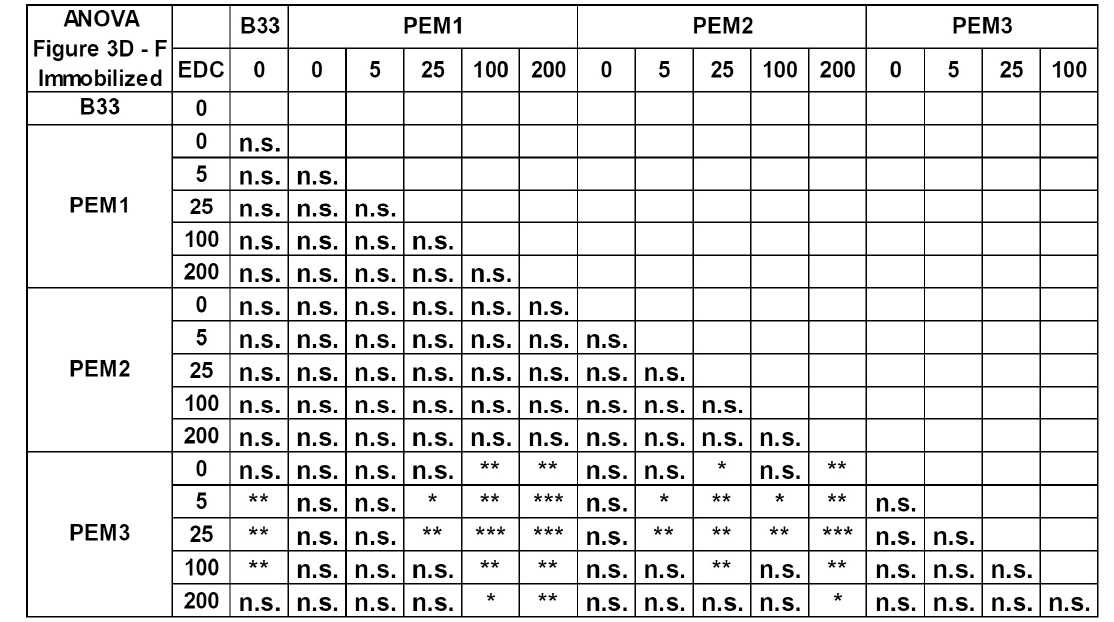
Figure A1. Results of one-way ANOVA for data related to Figure 3A–C; n.s.: not significant; *: p <